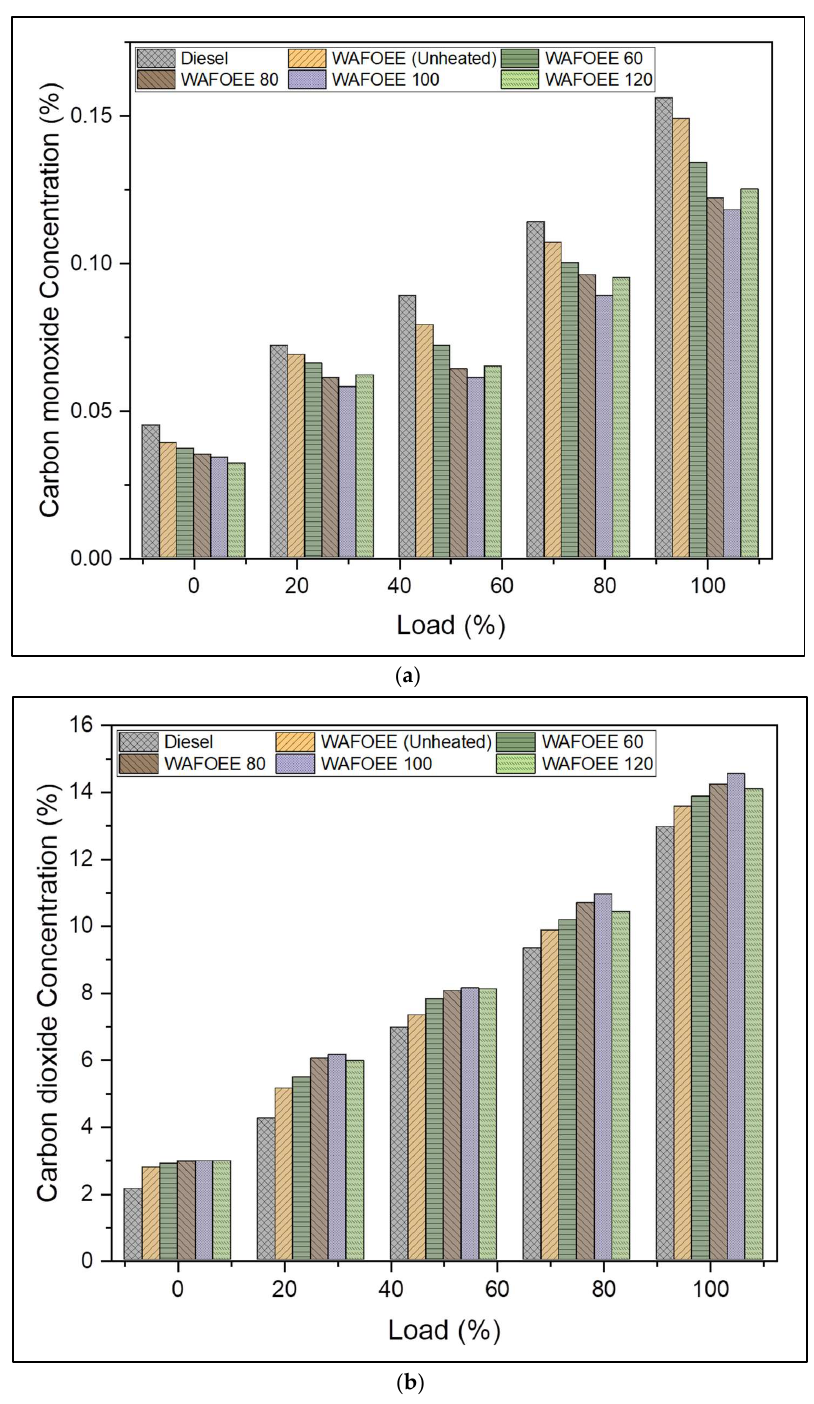
Figure 10. ( a ) CO emissions of neat diesel and biodiesel samples for varying engine loads; ( b ) CO 2 emissions of neat diesel and biodiesel samples for varying engine loads.